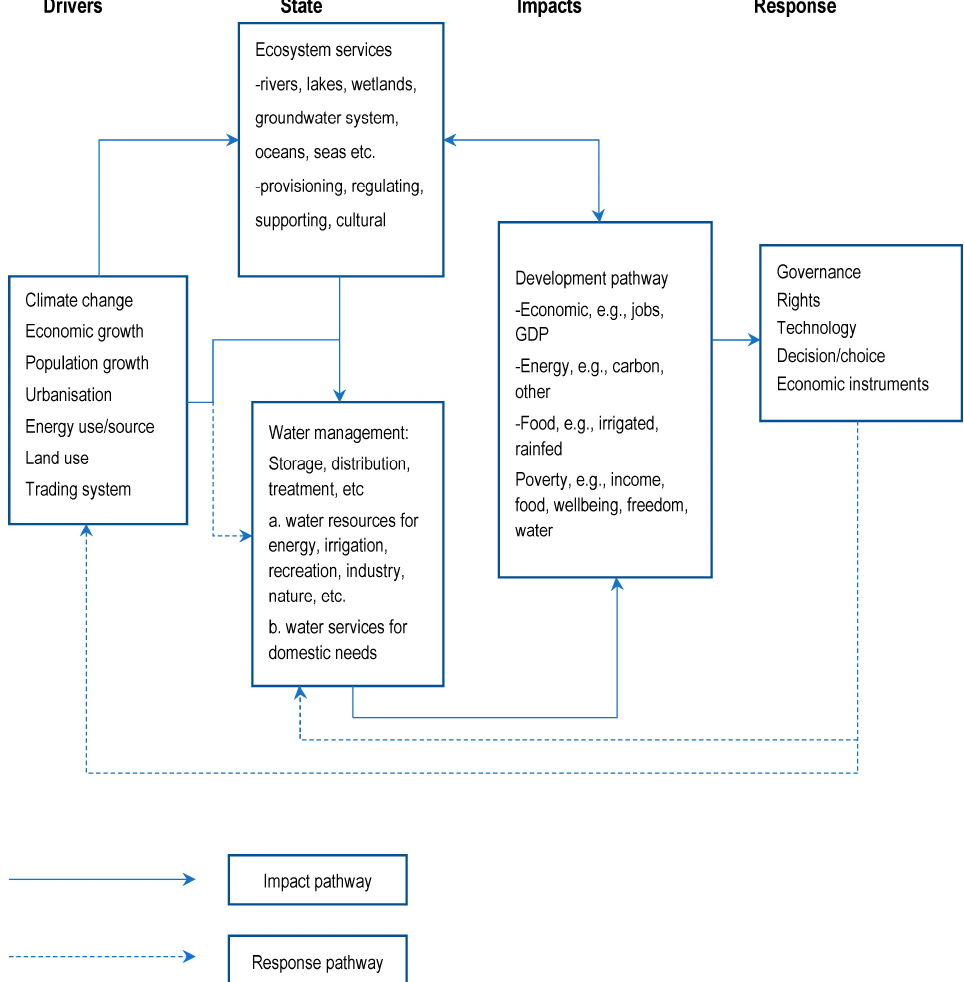
Figure 2. Conceptual framework. Source: [31].